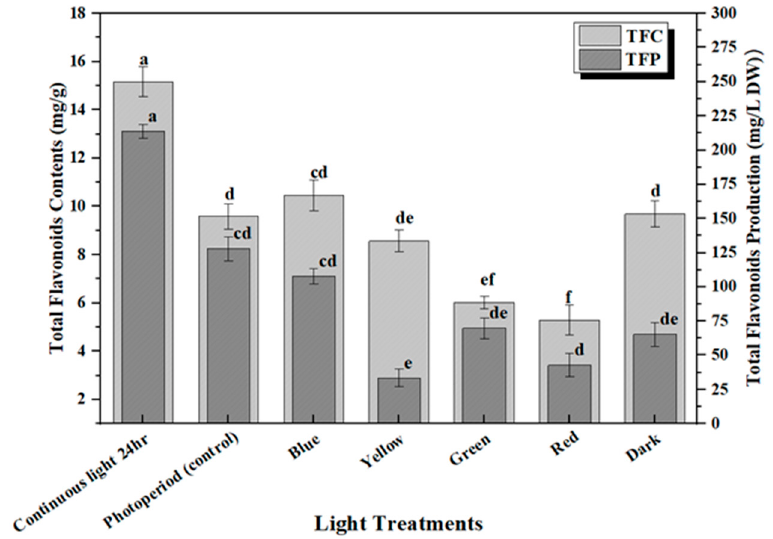
Figure 4. Differential effect of lights on TFC (mg/g DW) and TFP (mg/L) accumulation in in vitro callus cultures. The columns with similar letters are not statistically significant at p < 0.05.